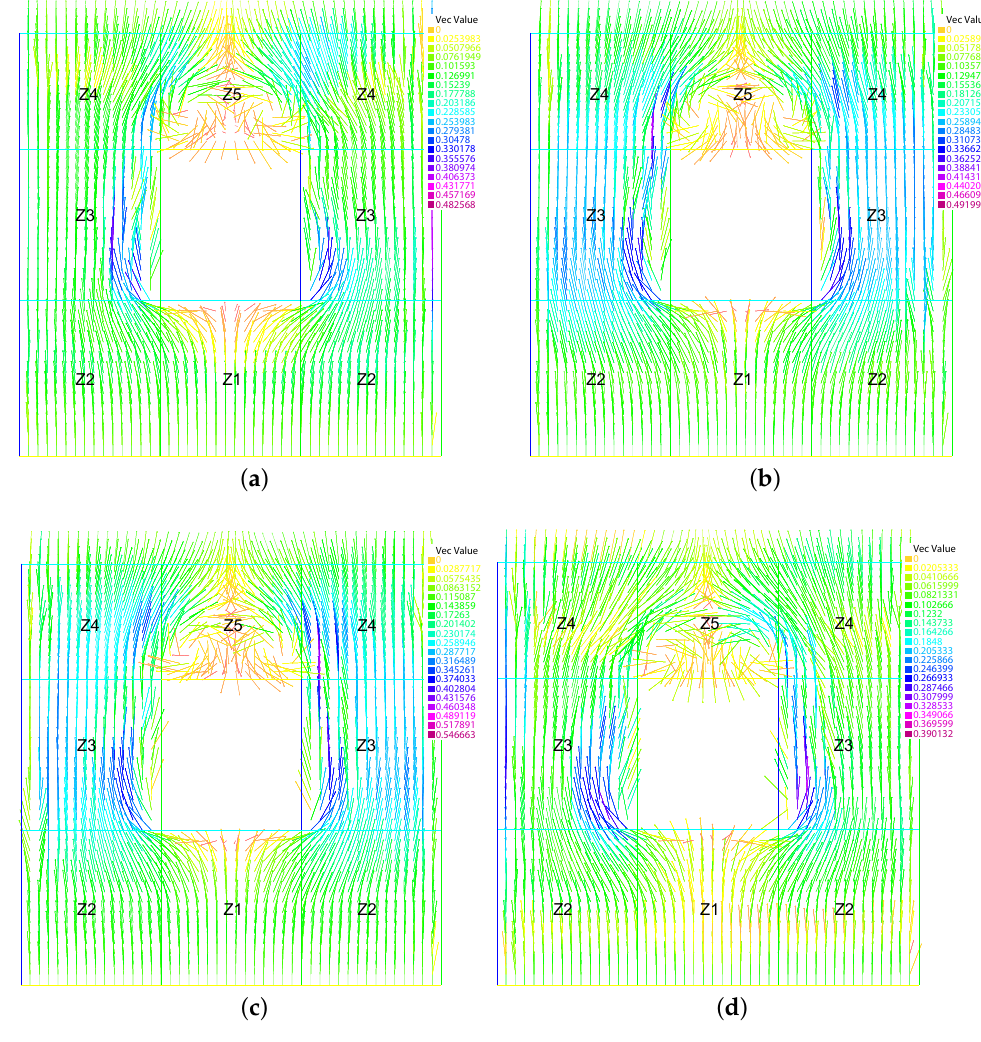
Figure 17. Velocity field of the air flow in the ventilated cavity of Cell 1 (OVF) for: ( a ) cutting plane at 0.02 m; ( b ) cutting plane at 0.04 m from the outer slab; ( c ) cutting plane at 0.06 m; ( d ) cutting plane at 0.08 m from the outer